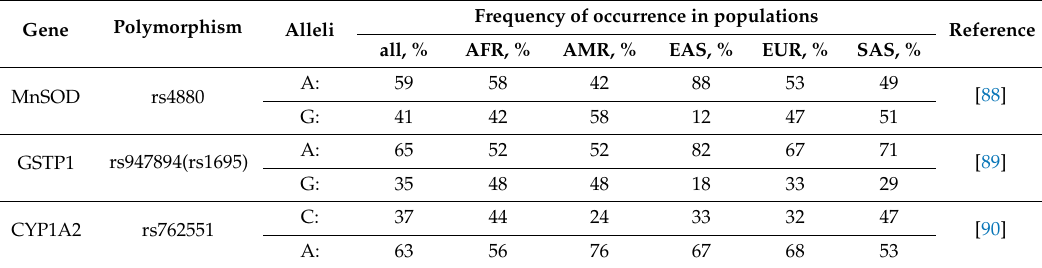
Table 5. Population genetics of genes responsible for metabolism of